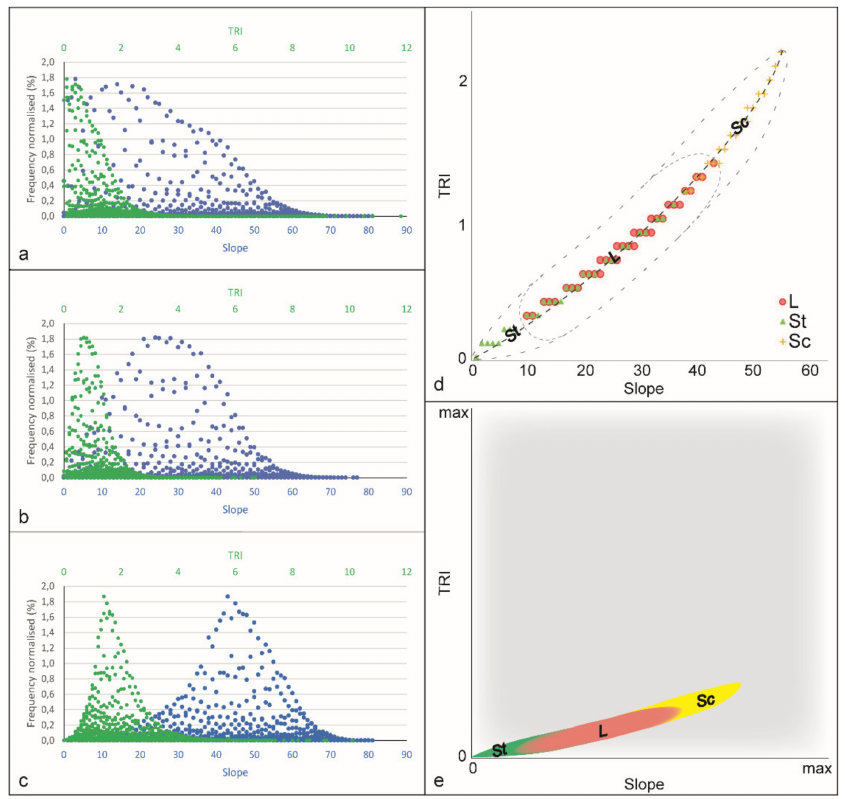
Figure 11. TRI and slope plots: ( a ) scatter plot of normalized frequency in stable areas; ( b ) scatter plot of normalized frequency in areas intersected by landslides; ( c ) scatter plot of normalized frequency in areas with scarp landforms; ( d ) TRI vs. slope plot indicating the grouping sector of stable areas (St), areas interested by landslides (L), and areas with scarp landforms (Sc); ( e ) TRI vs. slope plot obtained by constraining the correlation to the overall value range of each variable and indicating the clustering sector of stable areas (St), areas interested by landslides (L), and areas with scarp landforms (Sc).